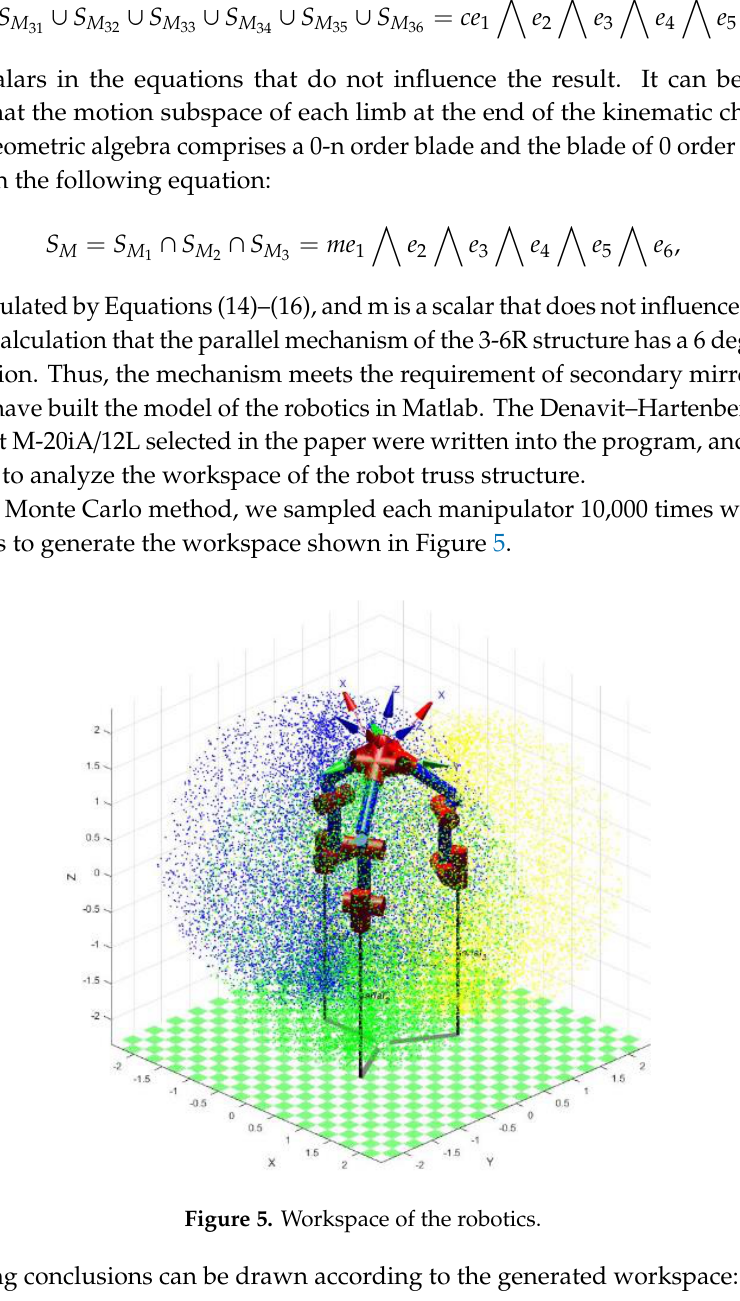
Table 4. Optical system parameters.